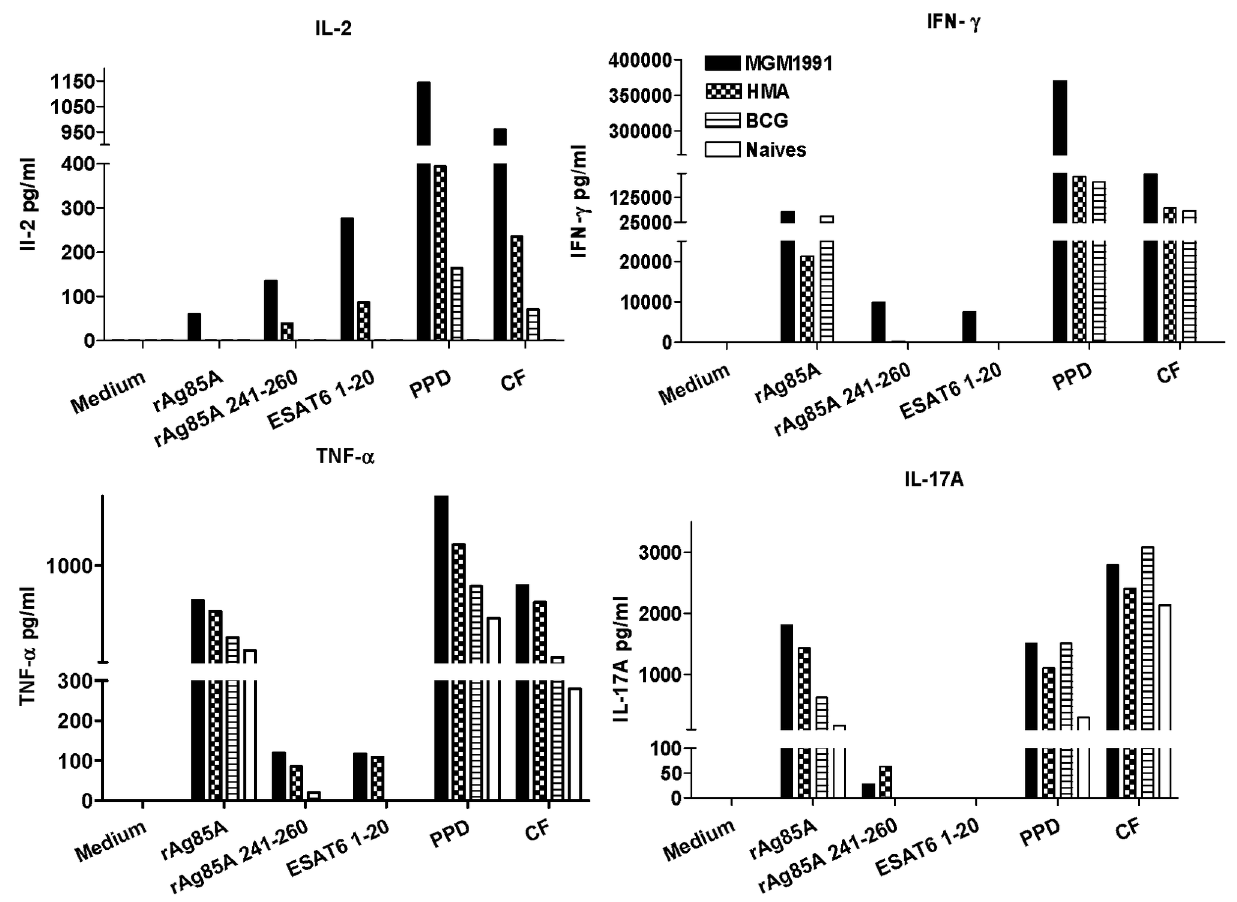
Figure 2. Cytokine production of draining lymph node cells of mice vaccinated with MGM1991, HMA or BCG vaccine. IL-2, IFN-γ TNF-α and IL-17A levels in culture supernatant of pooled inguinal lymph node cells of C57BL/6 mice vaccinated 4 weeks before with 5x10 4 CFU of MGM1991, HMA or M. bovis BCG by the subcutaneous route or from unvaccinated (naïve) mice and stimulated in vitro with recombinant Ag85A (5 µg/ml), with I-A b restricted immunodominant peptides spanning aa 241-260 of Ag85A or aa 1-20 of ESAT-6, with purified protein derivative PPD or with culture filtrate from M.tb culture filtrate CF (10 µg/ml). Cytokine levels are expressed in pg/ml (pooled cells from 5